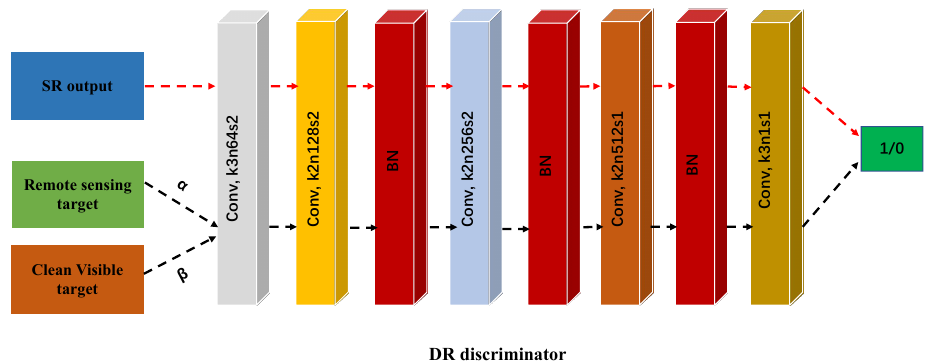
Figure 6. The architecture of the proposed DR